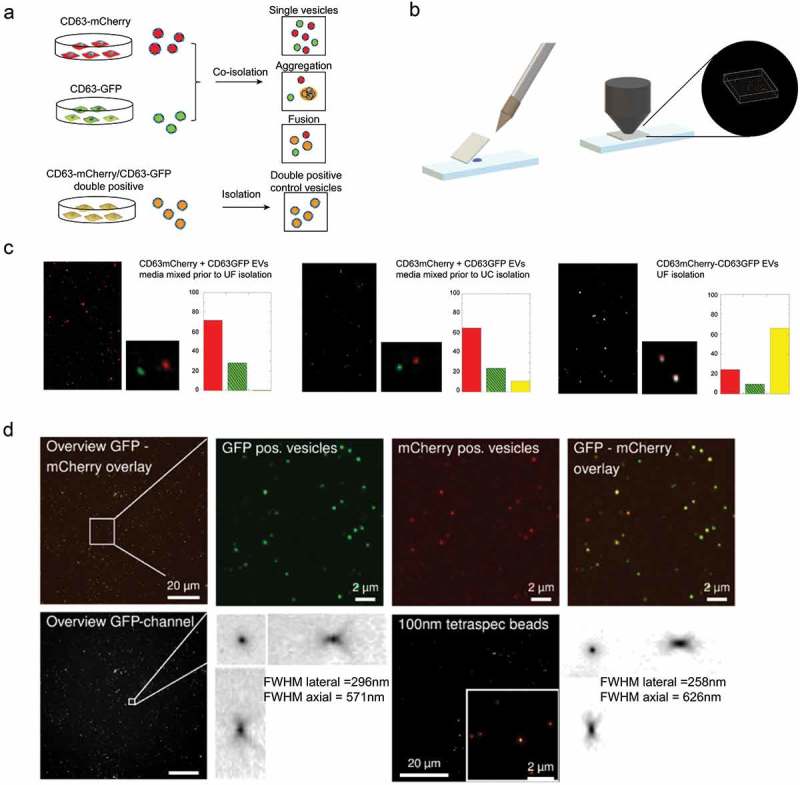
Single vesicle quantification of GFP-tagged reporters in CD63 positive vesicles.(a) HEK293T cells were transfected with either CD63-GFP or CD63-mCherry, conditioned media were mixed and EVs were co-isolated by different protocols to assess single vesicle integrity, aggregation or fusion. CD63-GFP-mCherry transfected cells were used as control. (b) 1 µl of EV sample was spotted onto glass slides, covered with 0.17 mm coverslips to generate a thin EV layer, and imaged by high NA confocal or widefield fluorescence imaging. (c) EVs from co-isolated media were detected as light diffraction-limited spots in either green or red channels with negligible occurrence of double-positive vesicles, confirming detection and integrity of single vesicles after UF-SEC (left panel). UC isolation resulted in a small fraction of double-positive vesicles (middle panel). Double labelled control EVs are shown in the right panel. The isolated EVs were analysed by confocal microscopy and the colocalization was quantified based on overlap of the point spread functions in the two fluorescent channels to derive the number of GFP (green, line pattern), mCherry (red) and GFP/mCherry (yellow) double positive vesicles. (d) CD63-GFP/mCherry double labelled control EVs imaged by high NA widefield fluorescence imaging, confirming a high degree of co-localization. The EV point spread function (PSF, bottom left) in comparison to the PSF of 100 nm Tetraspec beads (bottom right) confirms detection as light diffraction-limited spots. (e) Co-localization of different GFP-tagged EV proteins with CD63-mCherry EVs by single vesicle widefield imaging. Images are shown after deconvolution and as maximum intensity projections (MIPs from 5 µm z-stacks; red: CD63-mCherry; green: GFP. scale bar 2 µm). Co-localization quantification as indicated in the image. (f) Percentage of CD63-mCherry (red), GFP (green) and double-positive EVs (yellow) for the different GFP constructs (technical replicates shown as individual bars).